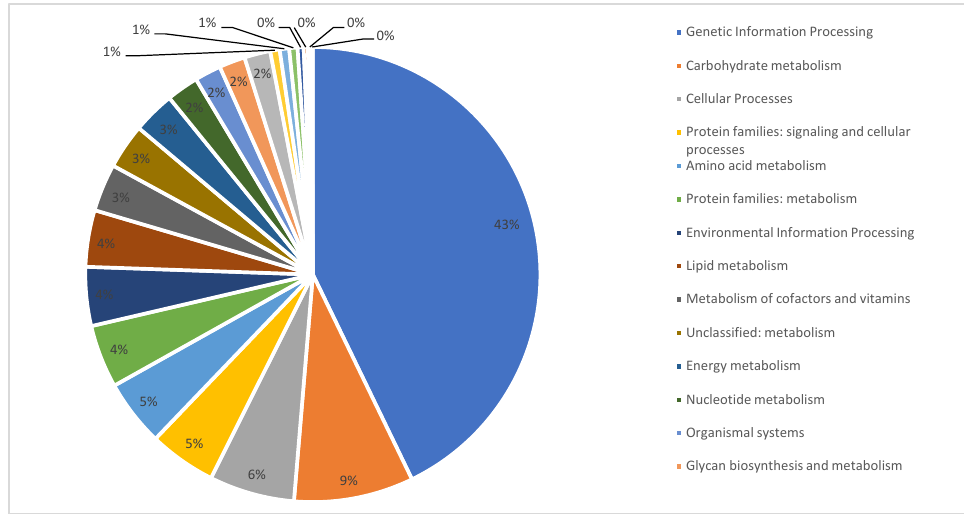
Figure 3. Proportion of genes of C. keratinophilum CBS 104.62 assigned to different KEGG functional categories, using BLASTKoala.